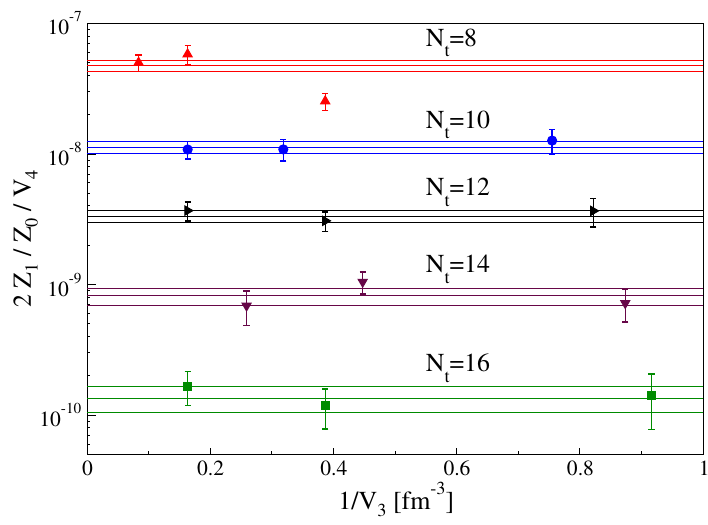
Figure 9 . Ratios of the partition functions with j Q j = 1 to that with j Q j = 0, divided by the four volume V 4 , for the same lattice spacings and volumes shown in (cid:12)gure 8, and compared with the in(cid:12)nite volume estrapolation of a(cid:31) 4 (horizontal